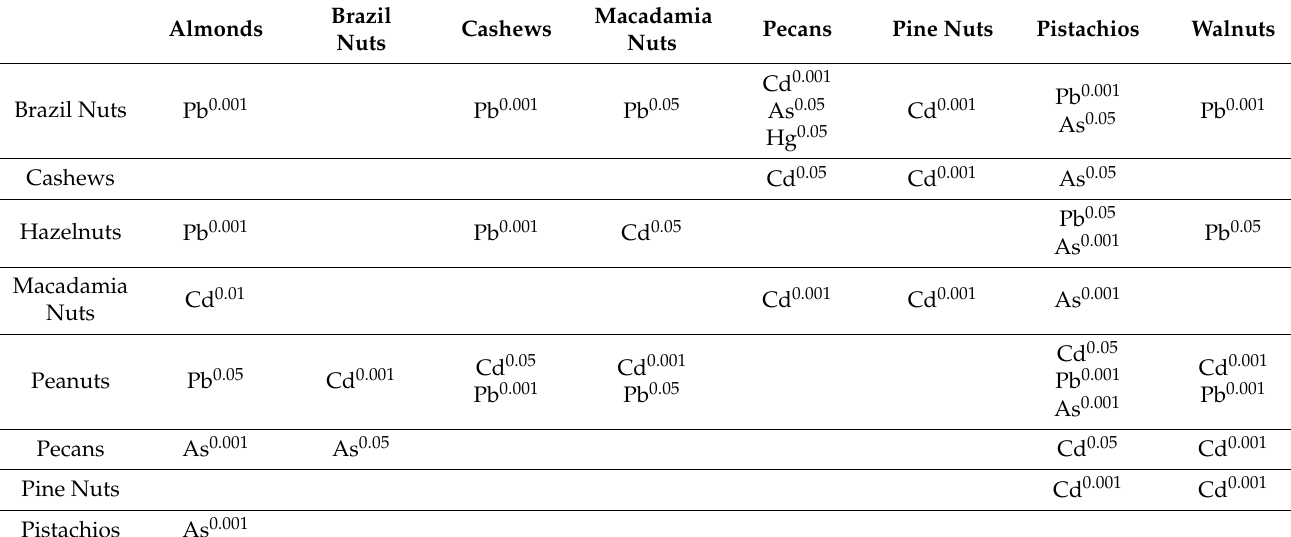
Table 2. Statistically significant differences in the content of the studied elements between tested nuts. Macadamia Brazil Pecans Pine Nuts Pistachios Cashews Almonds Nuts Nuts